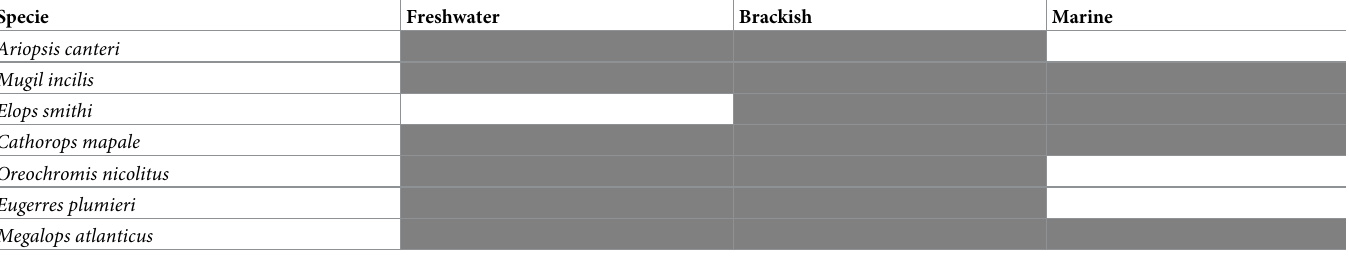
Table 1. Main species caught and salinity